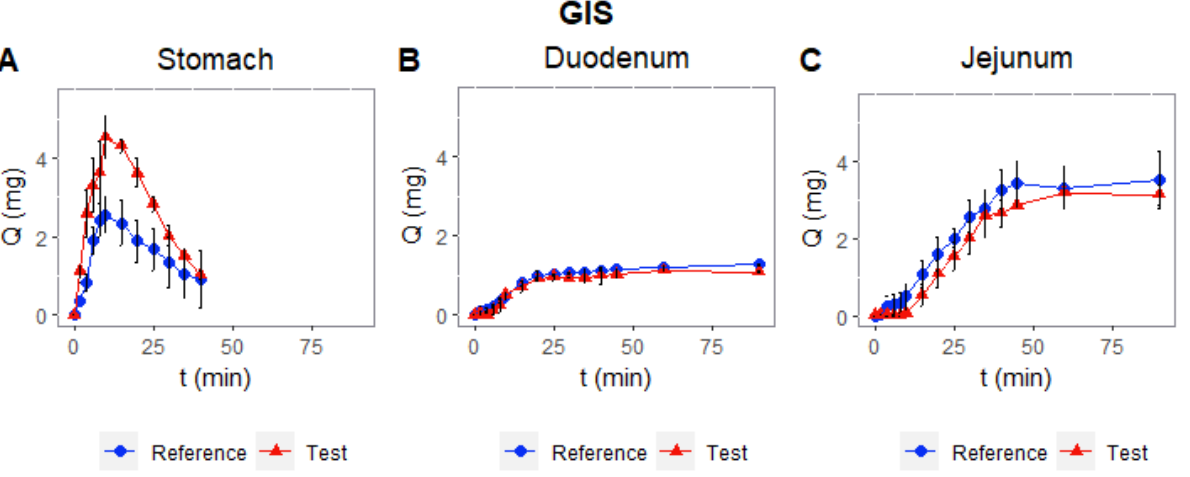
Figure 7. Experimental values of amount dissolved (%) for reference and test silodosin products in each GIS chamber (( A )—Stomach, ( B )—Duodenum, and ( C )—Jejunum). each GIS chamber (( A )—Stomach, ( B )—Duodenum, and ( C